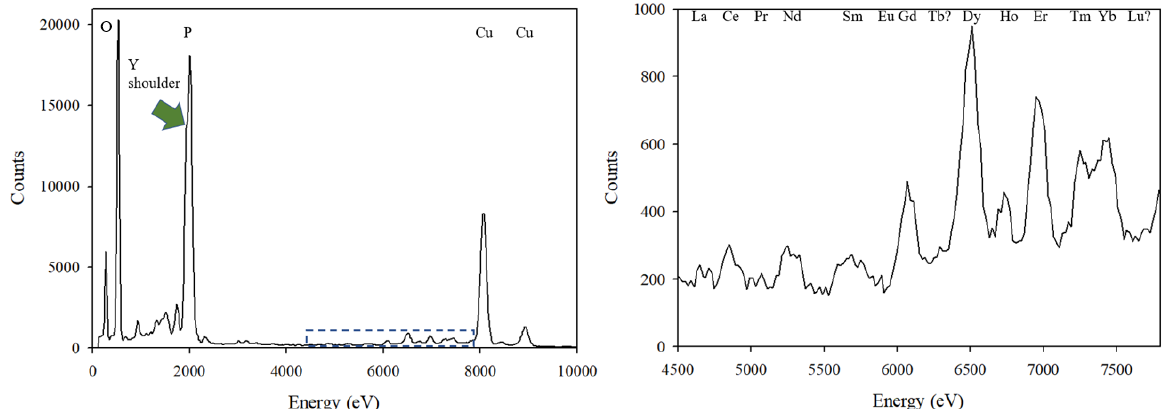
Figure 16. EDS for area 1 within area 1003. The full counts for the 0 to 10,000 eV range are shown on the left and a restricted count range for the 4500–7800 eV range is shown on right (dashed box on full-range figure indicates the area of the right figure). Yttrium appears as a shoulder on the P peak. The “peaks” for Eu, Tb, and Lu are not considered to be significant. The Cu peak belongs to the grid holder, not the sample.